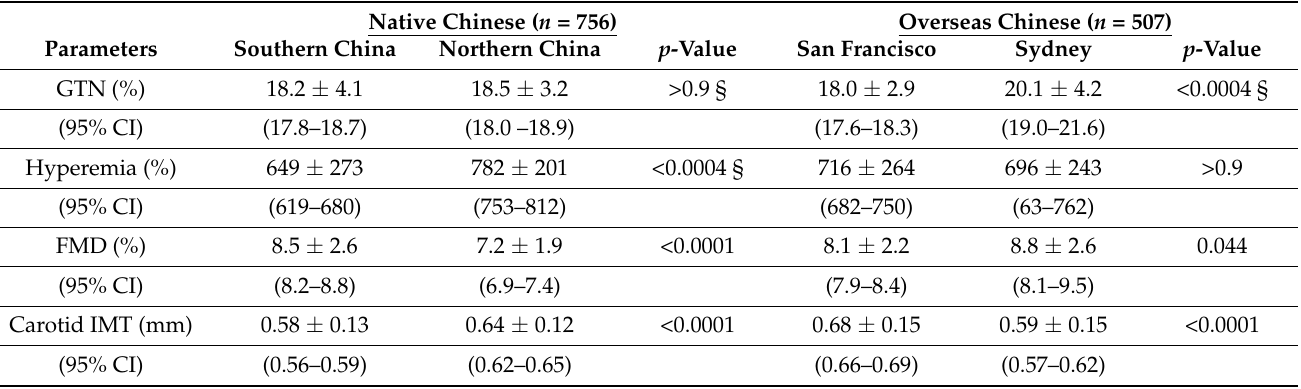
Table 4. Vascular parameters from different locations.